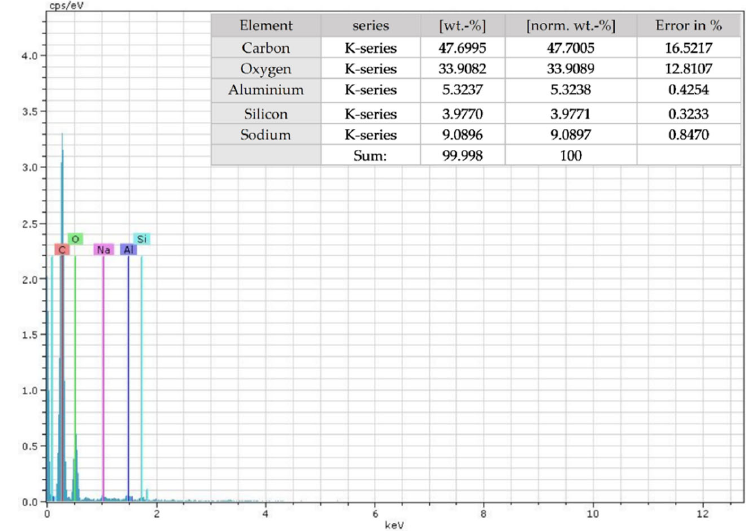
Figure 7. SEM micrograph of the varnish sample (yellow circles represent the analyzed areas).